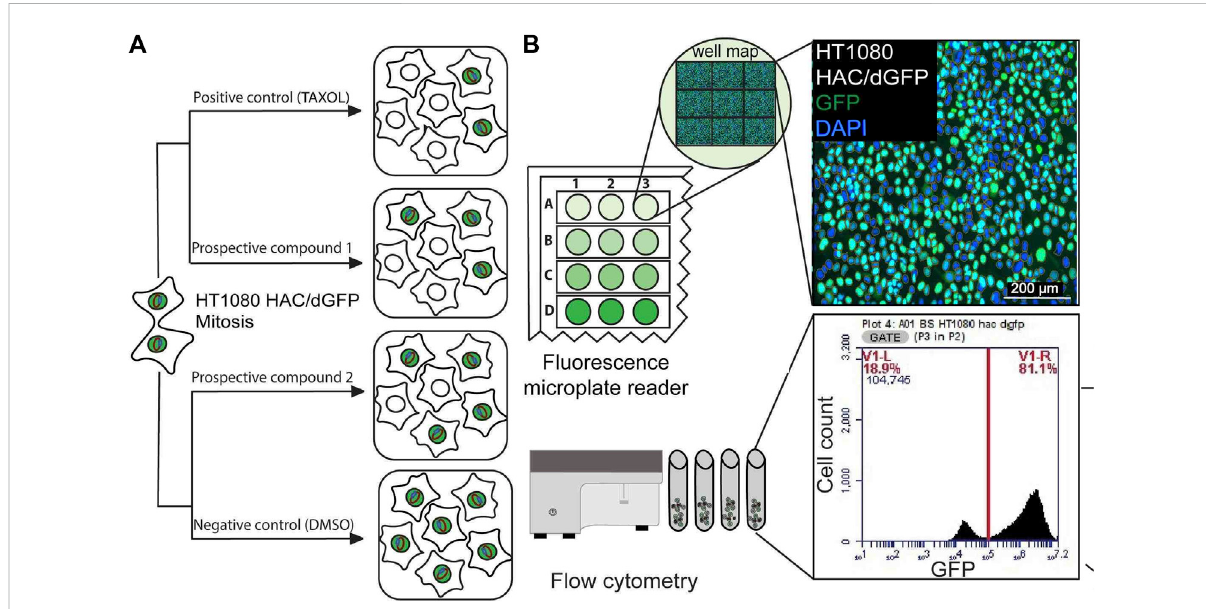
FIGURE 1 (A) A scheme of the HAC/dGFP assay. The assay is based on the use of the HAC/dGFP (the alphoid tetO -HAC containing the dGFP transgene). Cells with the HAC display green fl uorescence, while cells that lack it do not. It is expected that untreated cells ( “ a negative control ” ) should show uniform green fl uorescence. (B) A cell population, that has lost HAC upon treatment with the CIN-inducing drug ( “ a prospective compound ” ), loses GFP fl uorescence.For the positive control, we used Taxol, aCIN-inducing microtubule destabilizing agent. The actual number and